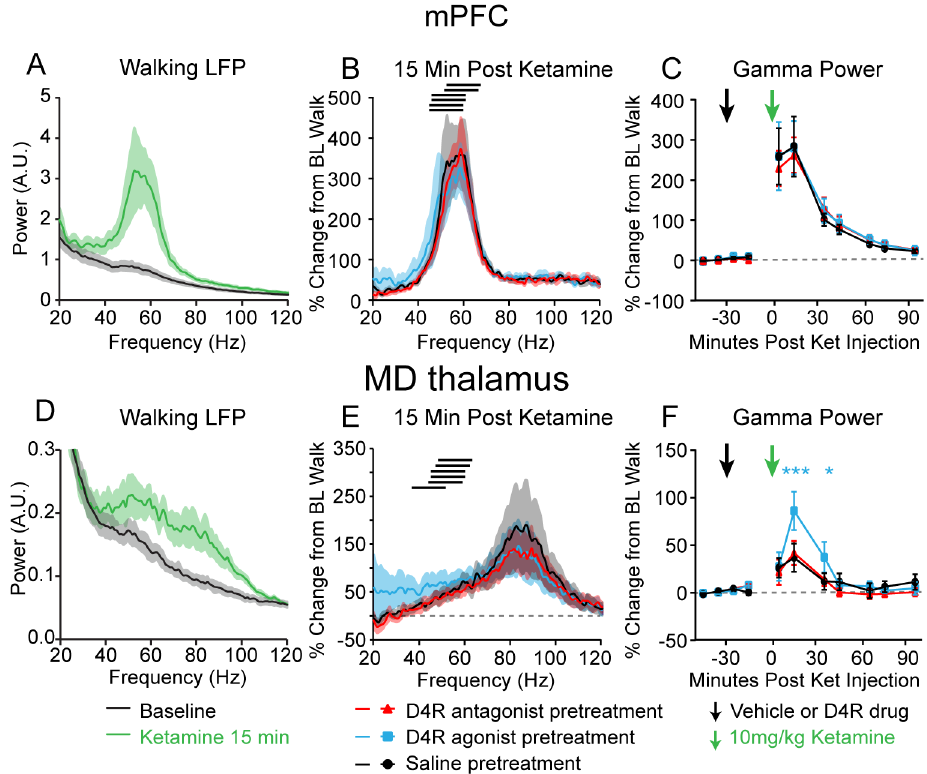
Fig 4. Effects of dopamine D4R agonist and antagonist on ketamine-induced gamma power. A, D, Averaged LFP power spectra in the mPFC ( A ) and MD thalamus( D ) at baseline(black) and 15 minutes after 10 mg/kg ketamine(green)with saline injection30 minutes prior to ketamineadministration (n = 6 rats). B, E, Average percent change in the mPFC ( B ) and MD thalamus( E ) in the LFP power spectra, relative to baseline walking,15 minutes after rats were injectedwith 10 mg/kg ketamine. The black bars indicatethe gamma frequency range of each individualrat. The red trace indicatespretreatment with the antagonist (5 mg/kg L- 745,870), the blue trace indicatesthe pretreatment with the agonist (3 mg/kg A-412997), and the black trace indicatesthe pretreatment with saline. All pretreatments were administered 30 minutes prior to ketamine, as shown in ( C ) and ( F ). Black traces are from the ketamineline spectra shown in ( A) and ( D) respectively. C, F, Changesin low gamma (peak between40 and 70 Hz ± 7 Hz) power from the frequencyranges shown by the black bars in ( B ) and ( E ) in the mPFC ( C ) and MD thalamus( F ), taken from 4 minute intervals 10–20 minutes apart, so that data was alwaystaken with the treadmill ON. The pre-treatment injection(black arrow) of saline (black trace), D4R agonist(blue trace) or D4R antagonist (red trace), was administered 30 minutes before the injectionof 10 mg/kg ketamine(green arrow). Blue stars indicate a significantchangefrom saline pretreatment with the agonist (n = 6 rats). Data is presented as percent change from the rat’s baselinewalking power on the same recordingday. Values are reportedas percentage ± SEM. ** : p < 0.01, *** : p < 0.001, two-way repeatedmeasures ANOVA followedby pairedbootstraptests with Bonferroni correction. timing and gamma oscillations; but in the MD thalamus, ketamine reduced firing rates and spike-LFP correlations in the gamma range. This data is consistent with results from studies in mice showing that ketamine increases glucose metabolism in the PFC and decreases metabo- lism in the MD thalamus [63,64]. By comparison, treadmill walking alone also increased gamma power in both the mPFC and MD thalamus, but to a lesser extent than ketamine administration and these effects were not additive. In the mPFC, walking concurrently increased firing rates of pyramidal neurons and spike synchronization to gamma oscillations, consistent with previous observations in the visual cortex of mice [65,66]. Moreover, in the MD thalamus, unlike the effect of ketamine, walking concurrently increased the firing rate and synchronization between spikes and gamma oscillations, suggesting that different mechanisms